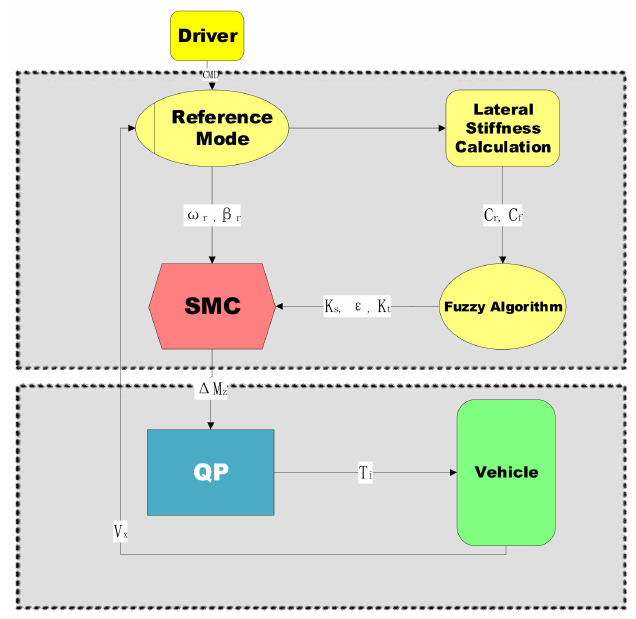
Figure 6. Block diagram of adaptive SMC.